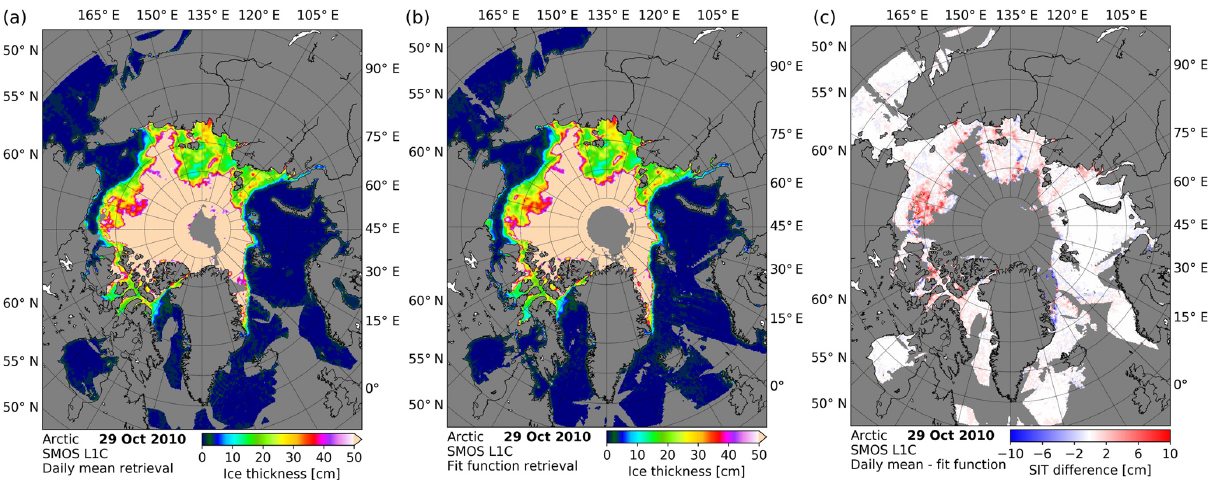
Figure 3. SMOS sea ice thickness retrieved on 29 October 2010 using the 6.20 retrieval (a) , the retrieval using 45 ◦ incidence angle fitted TBs (b) and the difference between the two (c) with areas over 50cm SIT not